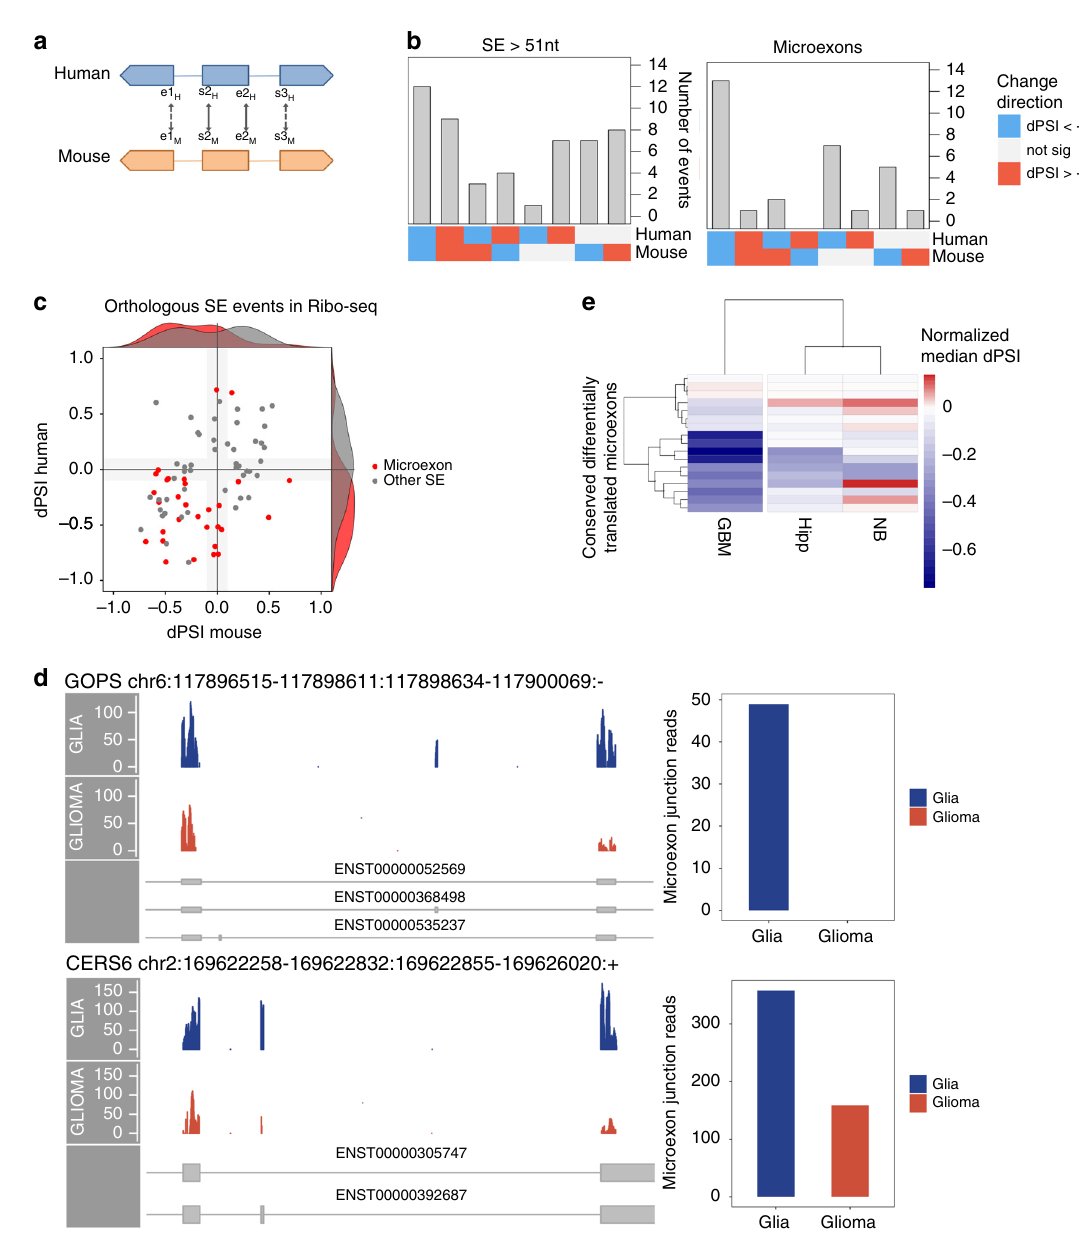
Fig. 5 A conserved program of differential RNA splicing and translation. a Conserved alternative splicing events were obtained by mapping with LiftOver the coordinates of the alternative exons (s2 and e2), and the internal coordinates of the fl anking exons (e1 and s3). We considered those alternative exons that had at least (s2 and e2) conserved. b Directionality of the changes in conserved alternative exons longer than 51nt (left panel) and microexons (right panel) in ribosome space. As before, dPSI indicates here the difference in relative abundance in both RNA and ribosome space. The plot shows the number of events ( y -axis) according to whether they were signi fi cant in human, mouse, or both, and the direction of change ( x -axis). We indicate in blue if the event had a signi fi cant decrease in inclusion smaller than − 0.1, and in red if the event had a signi fi cant increase in inclusion larger than 0.1. c Correlation between the difference in relative abundance (dPSI) in human on the y -axis and mouse on the x -axis for the conserved differentially spliced events in ribosome space. Microexons are depicted in red. d Examples of microexons that change signi fi cantly in RNA and ribosome space between glia and glioma. For the genes GOPC and CERS6 , we show Ribo-seq reads mapping to the microexon region and its fl anking exons (left panels) and the number of Ribo-seq reads crossing the microexon junctions (right panels) in both glia (in blue) and glioma (in orange). e Patterns of inclusion of conserved differentially translated microexons in normal hippocampus (Hipp) samples from GTEX, glioblastoma multiforme (GBM) from TCGA, and neuroblastoma (NB) from TARGET. The heatmap shows the difference of the median PSI with respect to the normal brain cortex tissue from